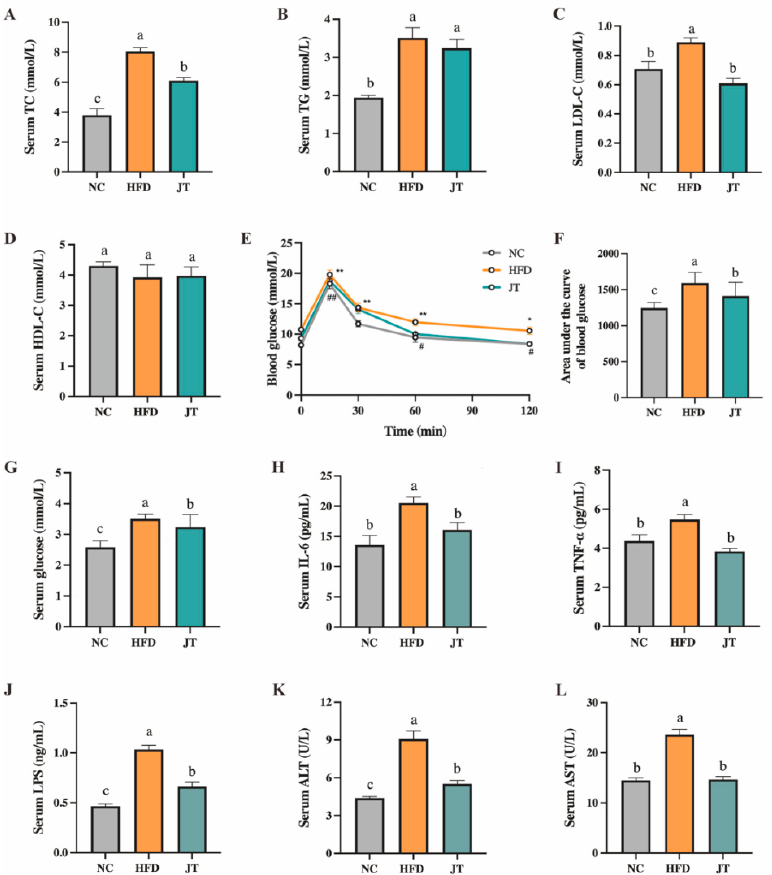
Figure 2. CB-JT improved the serum biochemical parameters in HFD-fed mice. ( A ) Serum TC. ( B ) Serum TG. ( C ) Serum LDL-C. ( D ) Serum HDL-C. ( E ) Blood glucose. ( F ) Area under the curve of blood glucose. ( G ) Serum glucose. ( H ) Serum LPS. ( I ) Serum IL-6. ( J ) Serum TNF- α . ( K ) Serum ALT. ( L ) Serum AST. NC: normal-chow group, HFD: high-fat diet group, JT: jasmine tea group. Data are expressed as the mean ± SEM. The mean value with different letters indicates significant differences ( p < 0.05). HFD vs. NC: * p < 0.05, ** p < 0.01; JT vs. HFD: # p < 0.05, ## p < 0.01, ns for no significance.